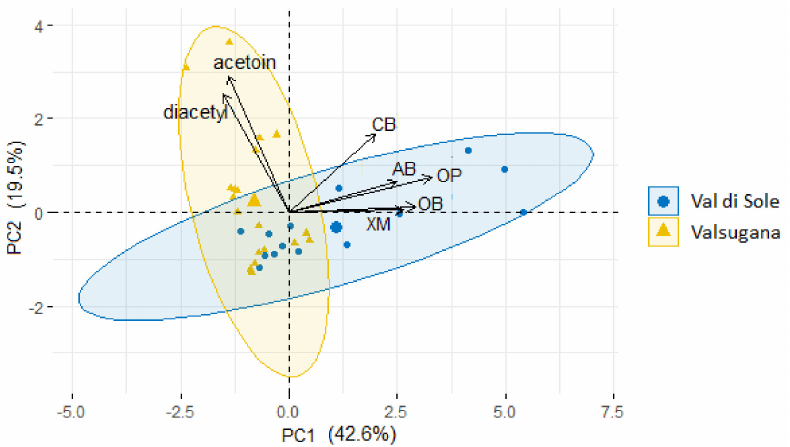
Figure 3. Plots of loadings and scores for principal components 1 and 2 (PC1 and PC2) obtained by principal component analysis